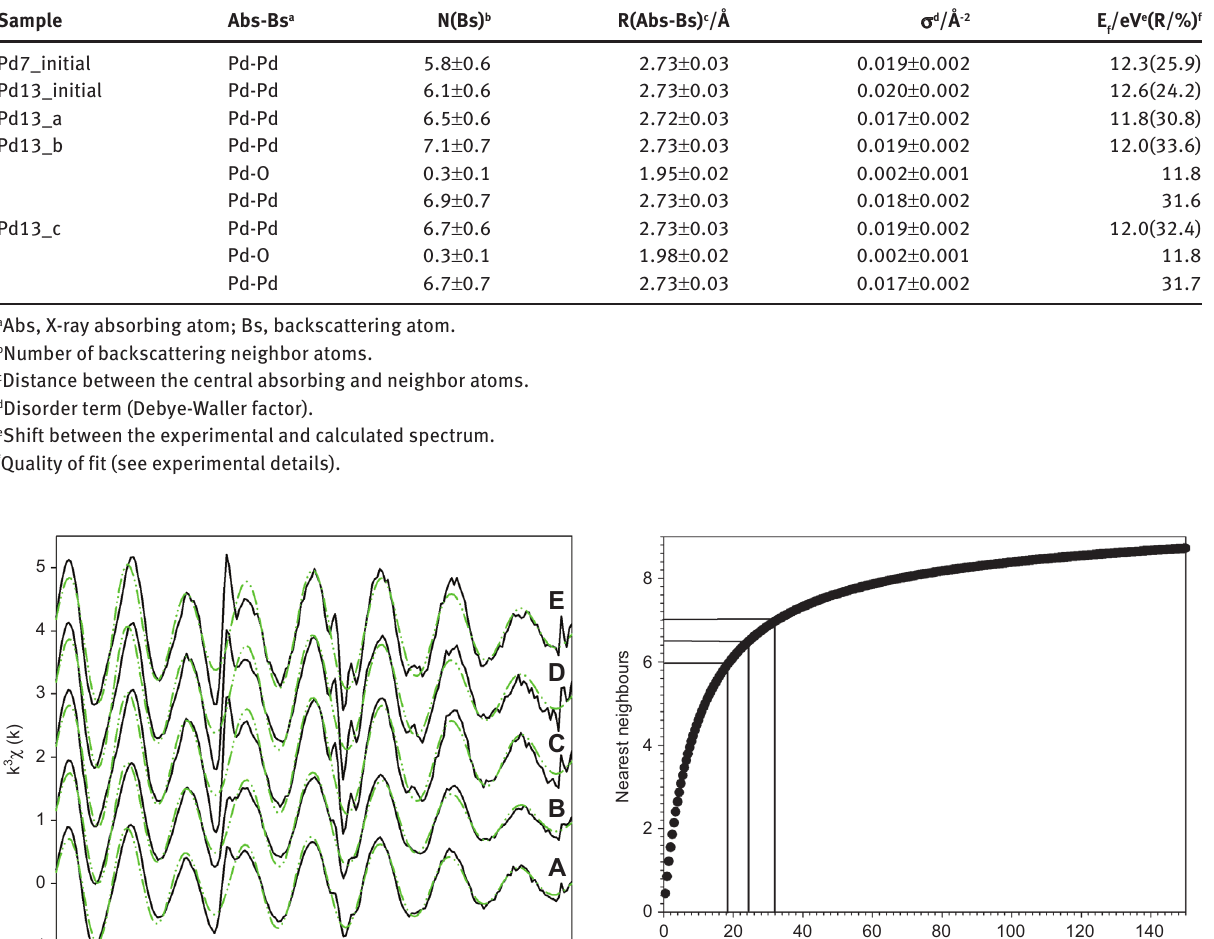
Table 4 Results from fitting the experimental spectra with theoretical models according to equation (1). Sample